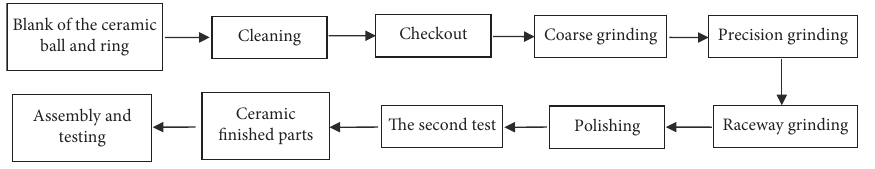
Figure 1: Processing route of full-ceramic bearing.